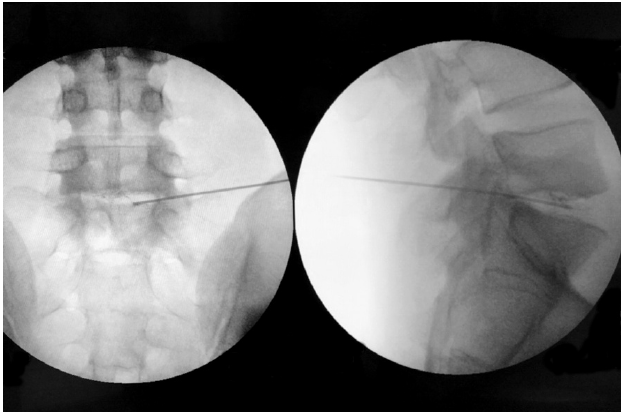
Figure 1. AP ( left ) and LAT ( right ) X-ray views of the ethanol gel injection under fluoroscopic guidance. The presence of tungsten in the gel provides a radiographic contrast effect as evidenced by contrast seen in the nucleus pulposus in the lateral